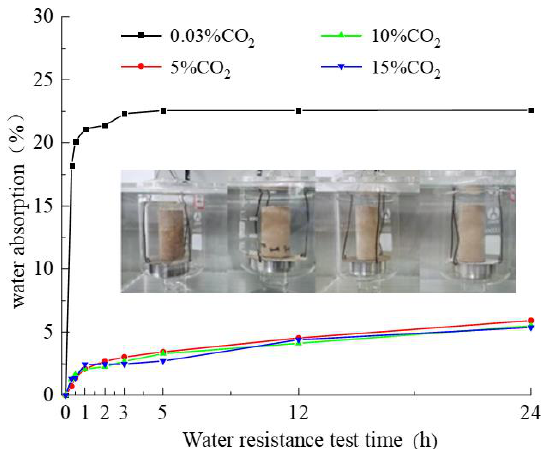
Figure 4. Effect of water absorption time on the water absorption rate of the specimen conditions. Figure 5. The water absorption of the specimens at 5%, 10%, and 15% CO 2 concentrations